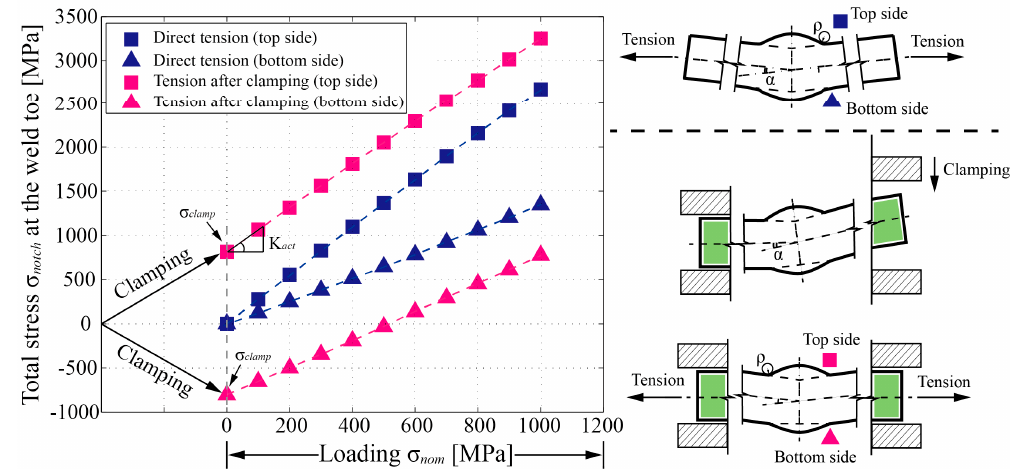
Figure 12. Total stress (the third principal stress for negative values, the first principal stress for positive values) at the weld toe of distorted butt-welded joints under two different loading processes, parameters: ρ / t s = 0.1, δ / t s = 0.1625, W / t s = 1.0, θ = 35 ◦ , α = 3 ◦ , L free / t s =